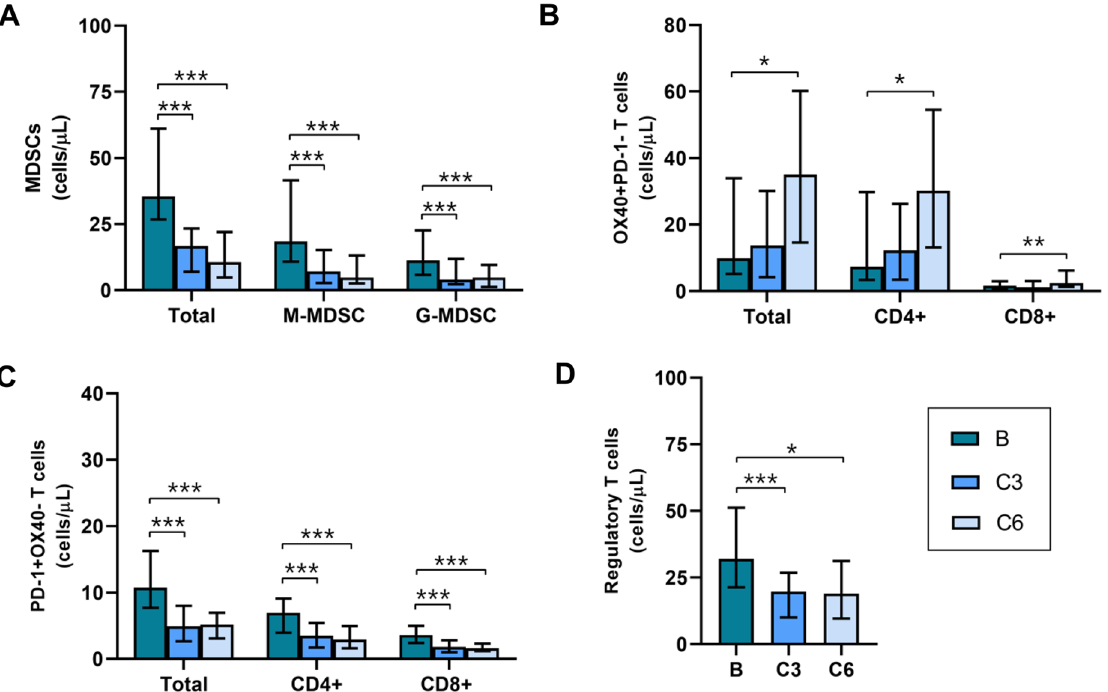
Figure 4. Basal, C3 and C6 medians of MDSCs ( A ), OX-40+ ( B ), PD-1+ ( C ) and regulatory T (D) lymphocytes levels (cells/ul) in ABC patients. MDSCs, myeloid derived suppressor cells; M‑MDSC, monocytic MDSCs; G‑MDSC, granulocytic MDSCs; Tregs, regulatory T lymphocytes; C3, cycle 3; C6, cycle 6. *, ** and ***, p ≤ 0.05, p ≤ 0.01 and p ≤ 0.001 compared with basal measurements, respectively. Different scales are used